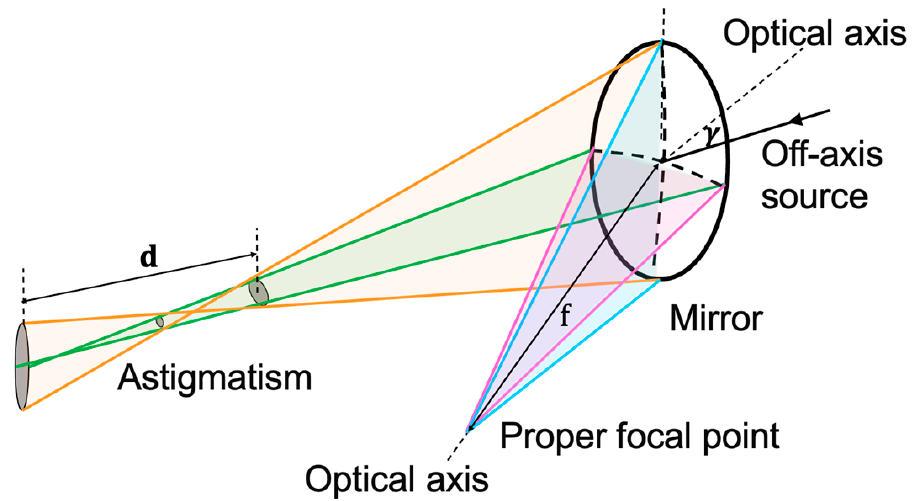
Figure 6. Schematic of astigmatism with the spherical mirror.